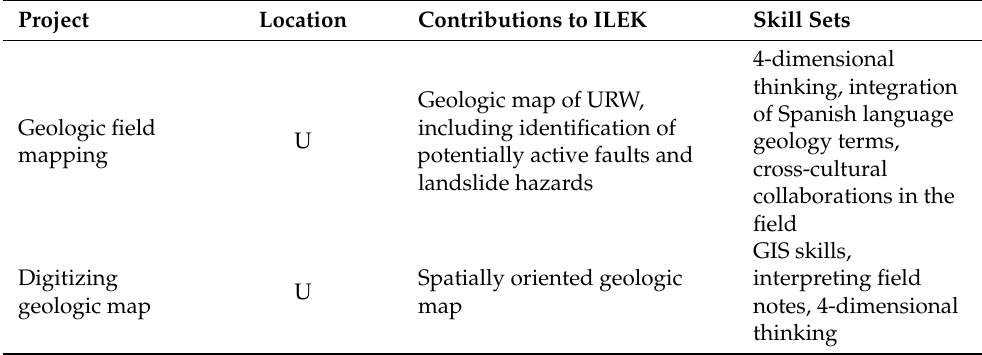
Table 1. List of student projects, contributions to ILEK in Zurite, and the skillsets acquired by students. For the locations, U indicates upstream, and D indicates